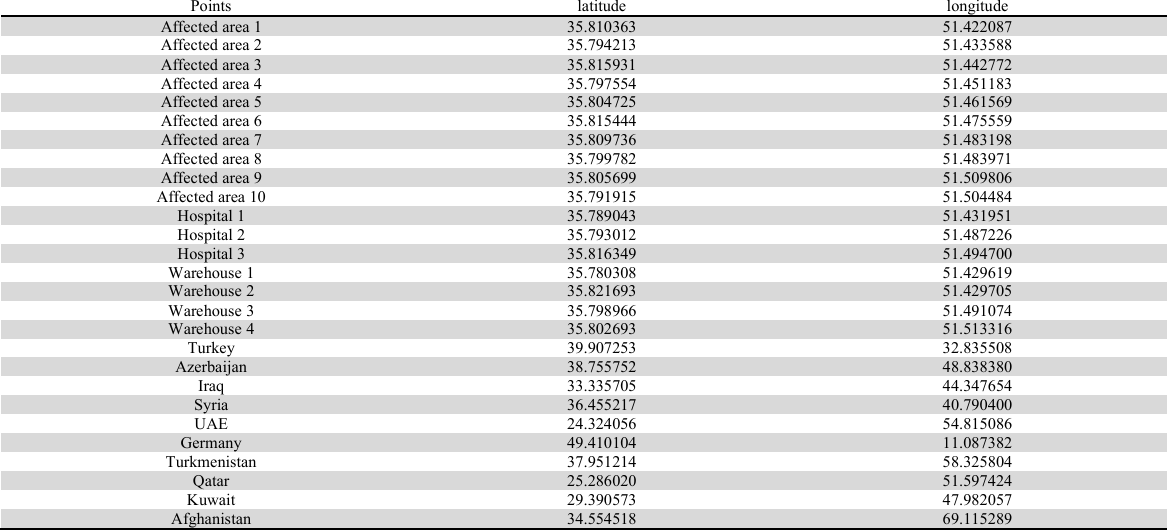
The latitude and longitude of the affected areas, medical centers, warehouses and international suppliers Points